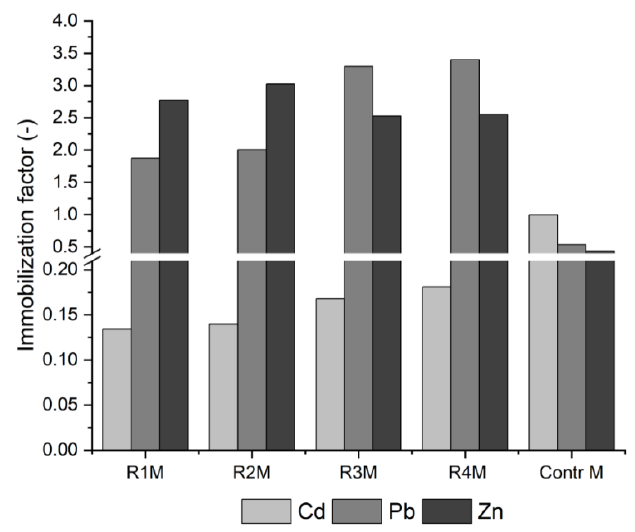
Figure 7. Immobilization factors of heavy metals in soil from the zinc smelter area.